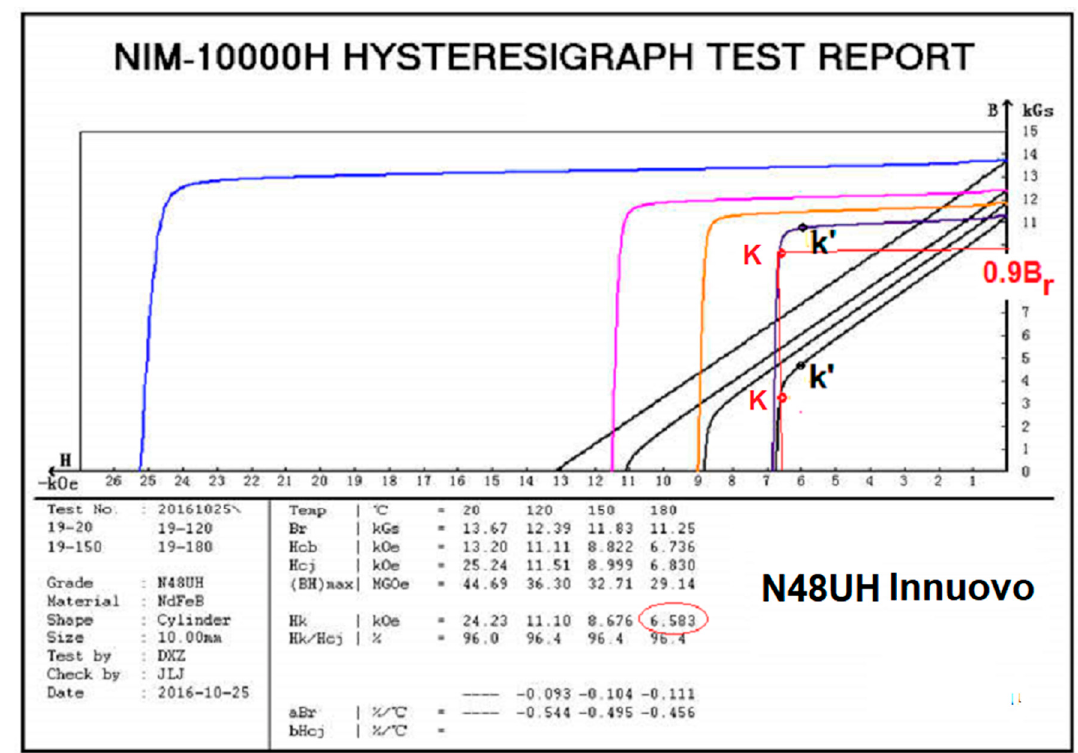
Figure 2. For Innuovo’s N48UH grade, the classic knee point K lies inside the nonlinear segment. Therefore, a minute decrease in H can result in a sharp fall in the flux density.